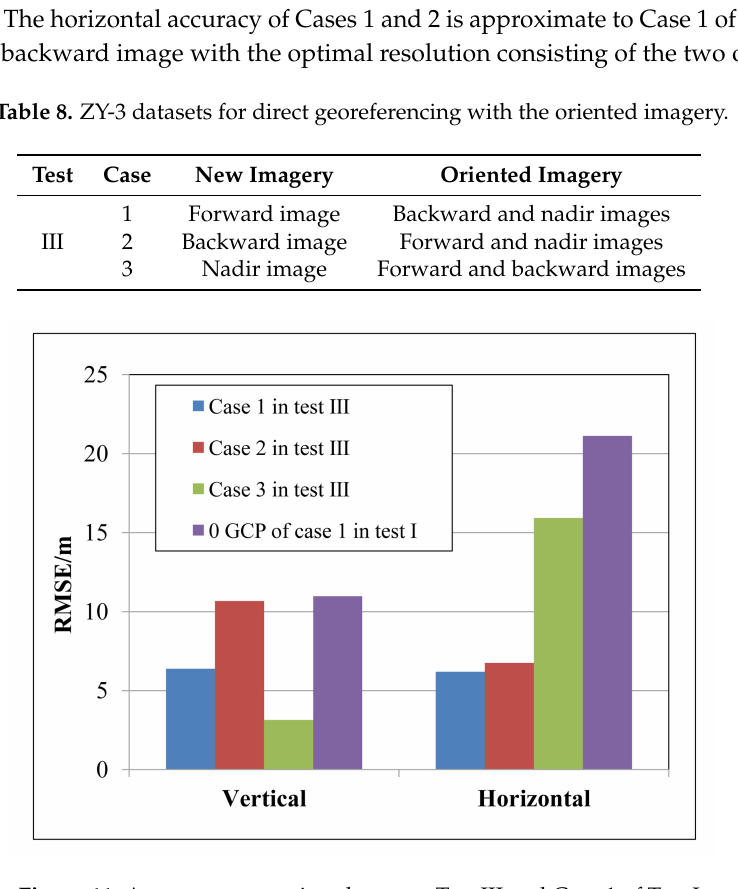
Figure 11. Accuracy comparison between Test III and Case 1 of Test